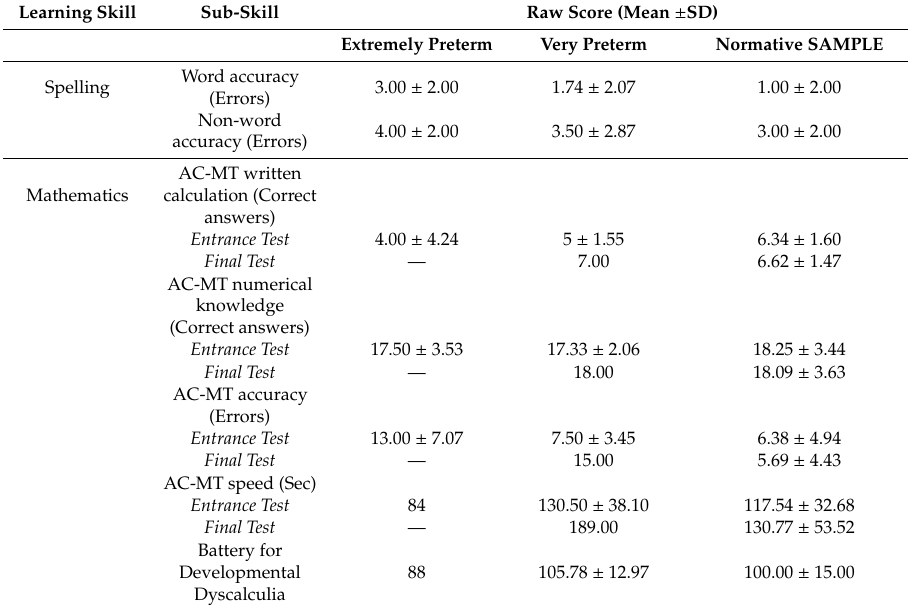
Table A2. Raw scores in learning skills in fourth grade children.